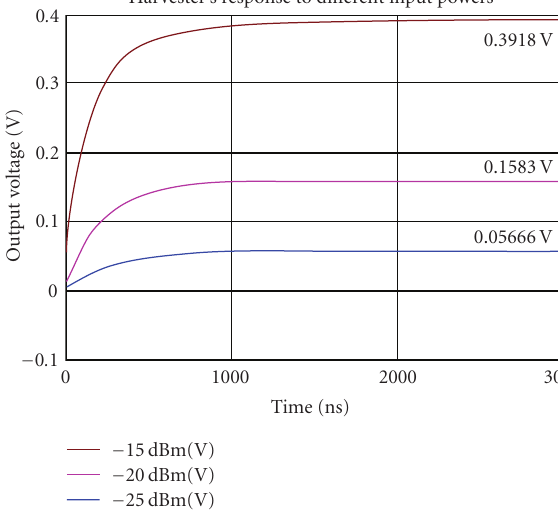
Figure 11: Harvester’s Response to a − 15, − 20, − 25 dBm Input.